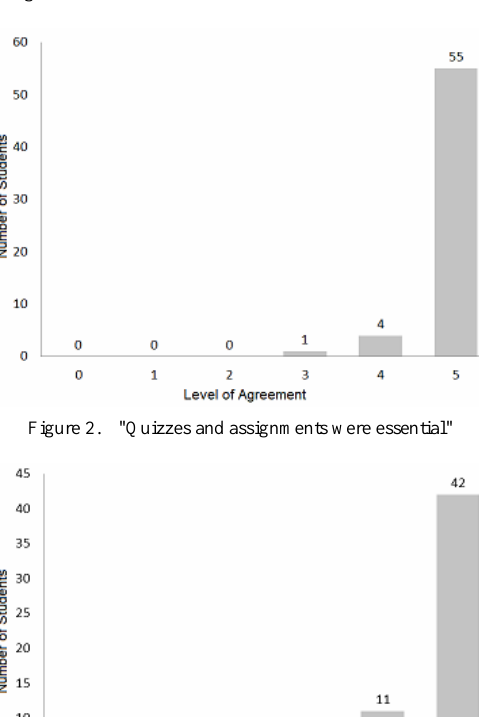
Figure 1. "Online activities were relevant for the course"